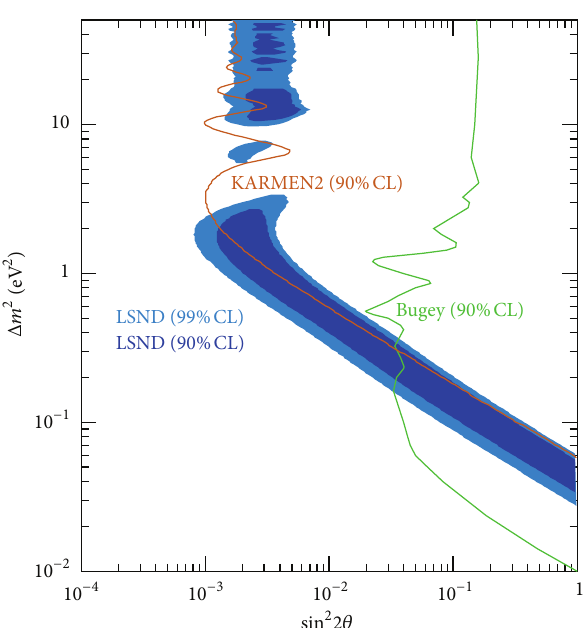
Figure 7: The ( sin 2 2𝜃, Δ𝑚 2 ) oscillation parameter fit for the entire LSND data sample, 20 < 𝐸 𝑒 < 200 MeV. The inner and outer regions correspond to 90% and 99% CL allowed regions, while the curves are 90% CL limits from the Bugey reactor experiment and the KARMEN experiment at